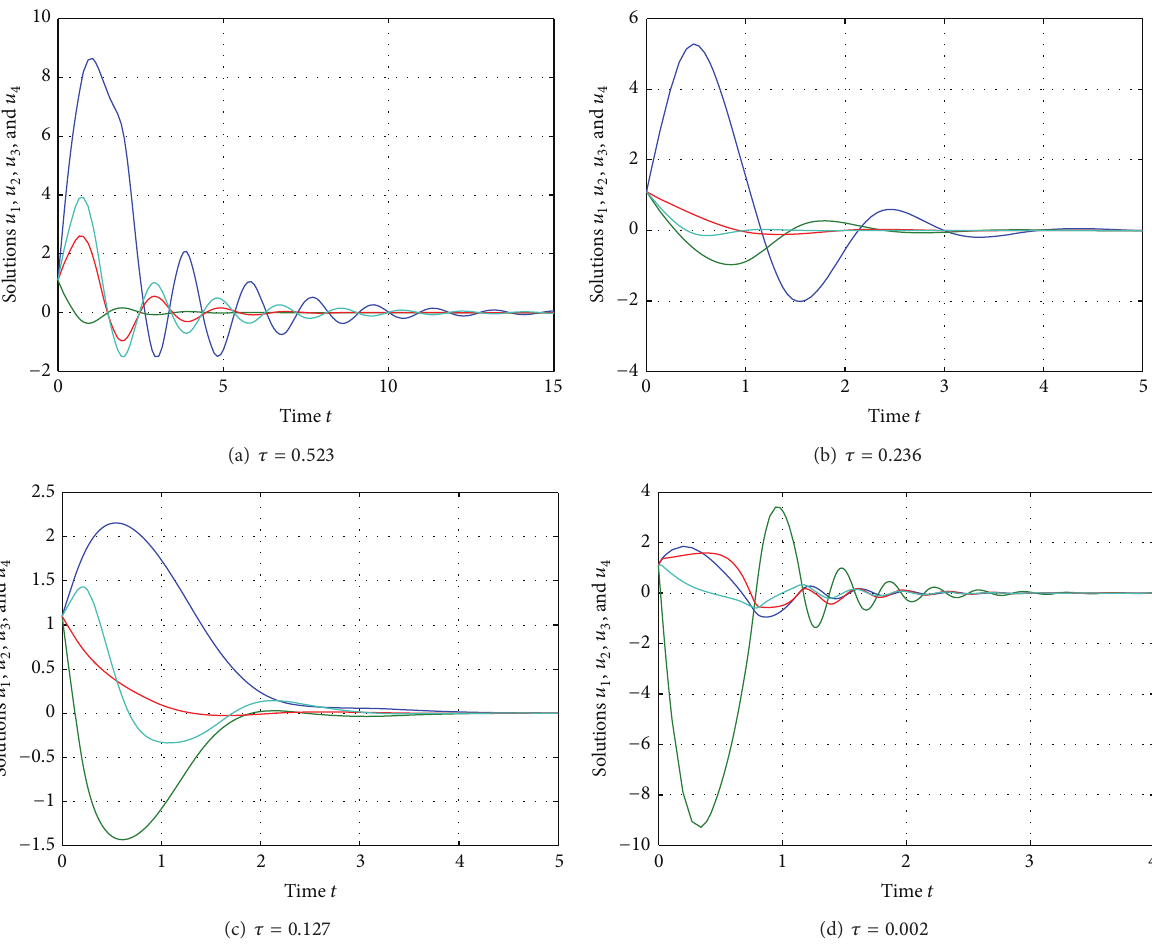
Figure 2: Time histories of system (3) when 𝑛 = 4 (Example